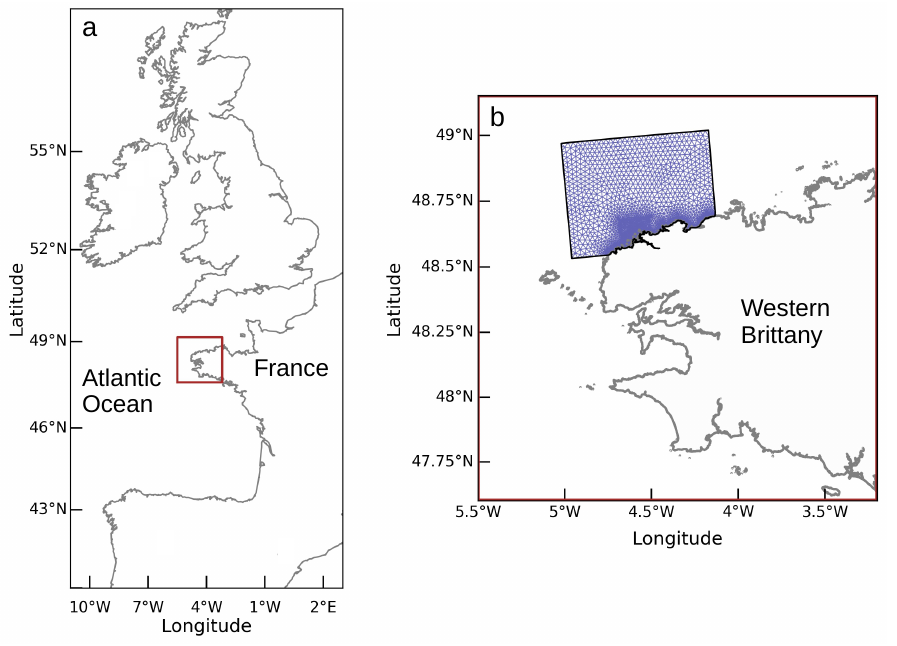
Figure 1. ( a ) Location of the study site in north-western European shelf seas. ( b ) Extent of the offshore computational domain in north western Brittany.